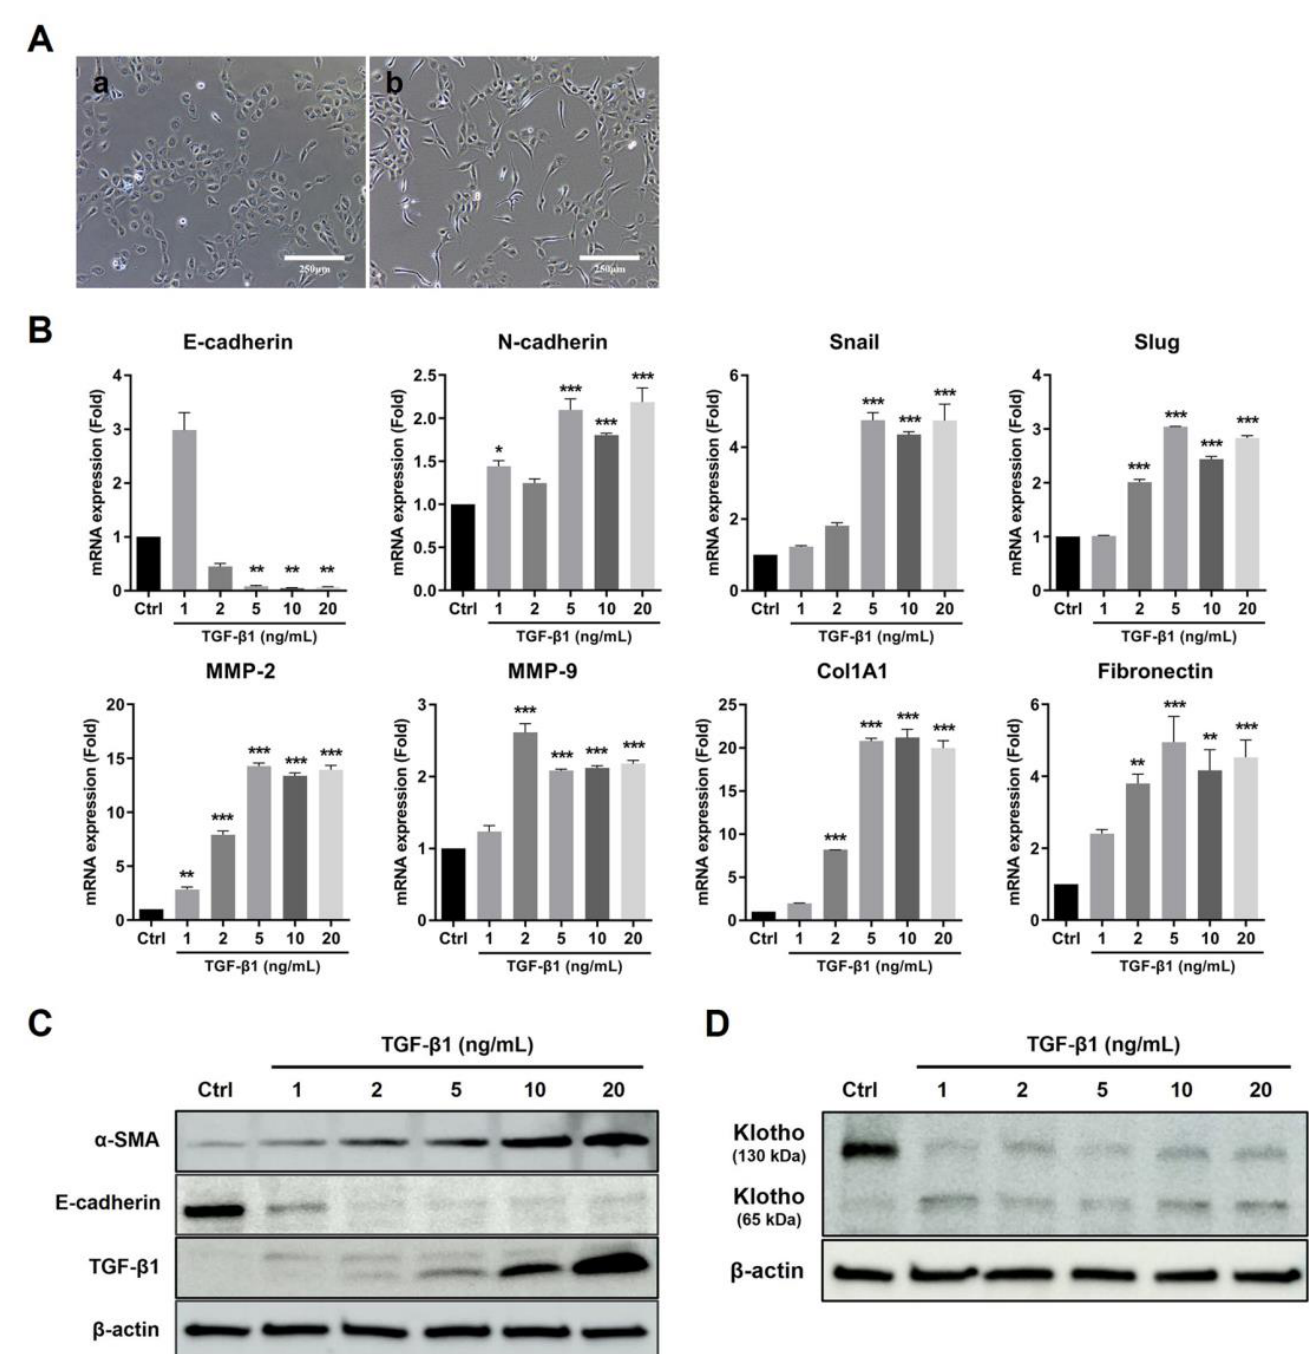
Figure 3. TGF- β1 -induced HK-2 fibrosis model. ( A ) HK-2 cells were treated with 10 ng/mL TGF- β1 for 72 h. The morphological changes were observed using a microscope. ( a ) Normal HK-2 cells. ( b )